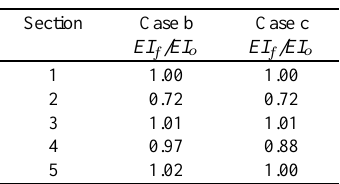
Table 7 Coefficient changes estimation